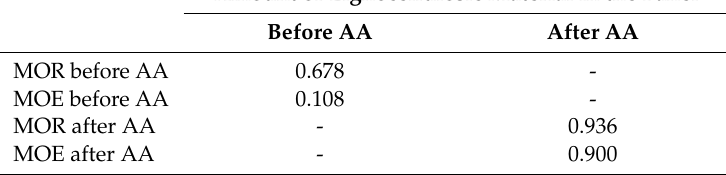
Table 5. Correlation values of the amount of lignocellulosic material in the panel and modulus of rupture (MOR) and modulus of elasticity (MOE) of the lignocellulosic composites before and after the accelerated ageing (AA)